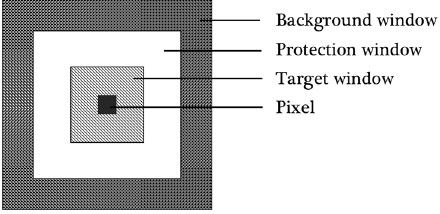
Figure 14. Relationships of three different sliding windows in two-parameter CFAR.